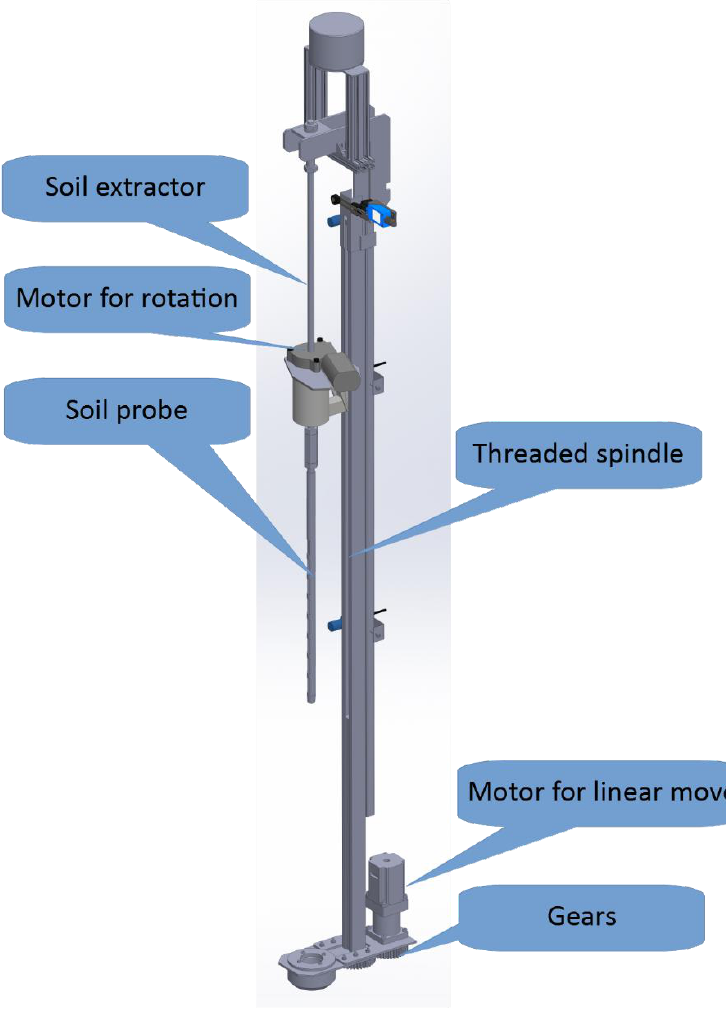
Figure 6. Model of the sampling module.